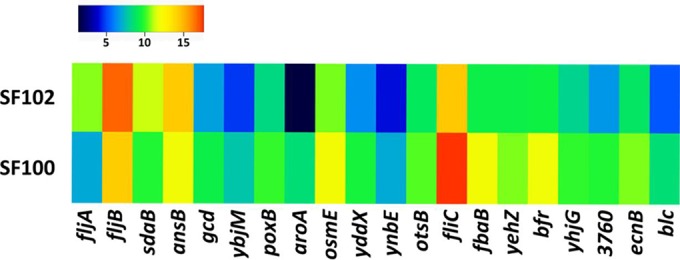
In vitro transcriptome analysis of SF100 (ΔlpxR9 ΔpagL7 ΔpagP8) and SF102 (ΔlpxR9 ΔpagL7 ΔpagP8 ΔaroA). Expression profile of the most prominent differentially regulated genes in the aroA-deficient mutant SF102 in comparison to its parental strain SF100. Normalized reads for particular genes are shown.